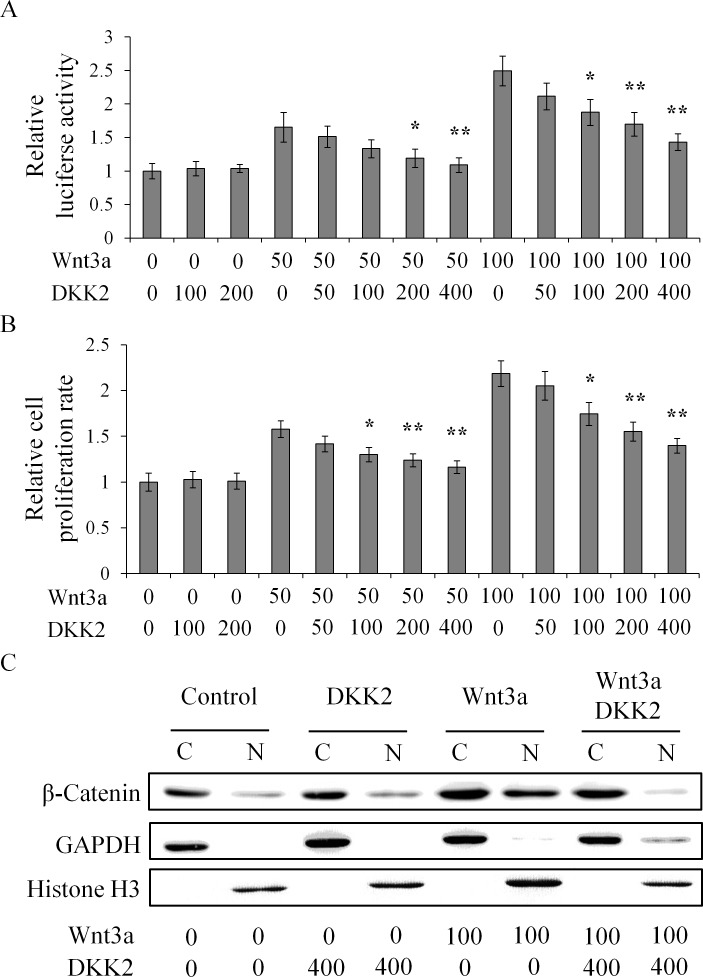
DKK2 inhibits Wnt3a-induced Wnt/β-catenin signaling.HuH-7 cells were transiently transfected with a TCF reporter plasmid and were then incubated with various concentrations of Wnt3a and/or DKK2 (ng/ml). The presence of the Wnt3a ligands activated the Wnt signaling pathway in a dose-dependent manner, as measured by elevation in the luciferase reporter activity (A). Consistently, cell proliferation increased in HuH-7 cells when they were cultured in the presence of Wnt3a ligands (B). Nuclear translocation of β-catenin was analyzed in (C), and GAPDH and Histone H3 were used to indicate cytoplasmic or nuclear fractions, respectively. Note that DKK2 addition abrogated the effects of Wnt3a significantly. * p < 0.05, ** p < 0.01 when compared to DKK2 stimulation in their respective Wnt3a levels.